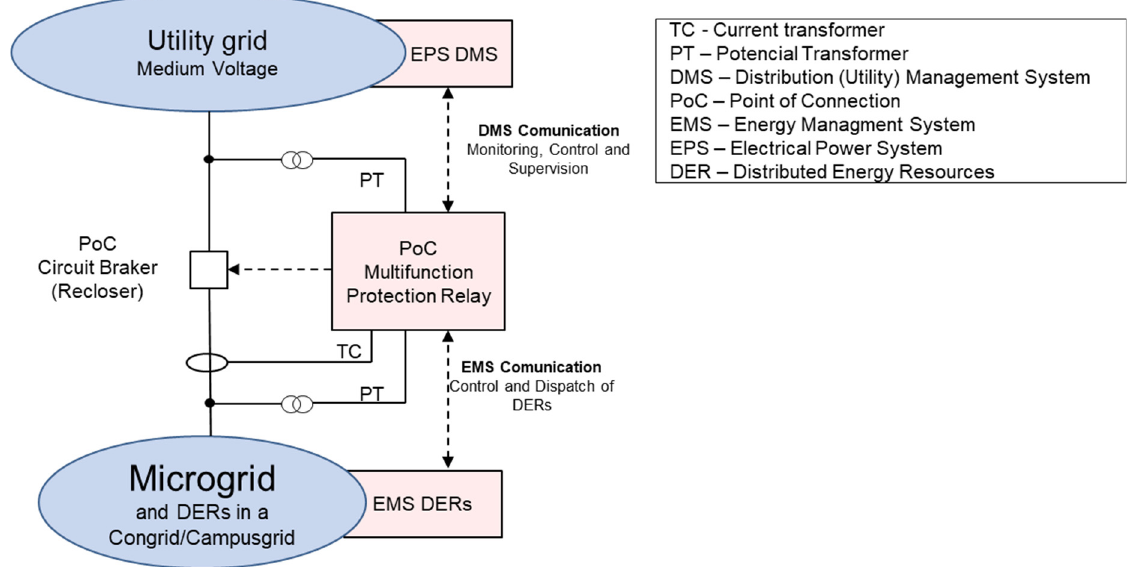
Figure 8. Connection structure of a microgrid to the utility distribution system using a protection relay for islanding, with synchronization and dispatch functionality via EMS or DMS.